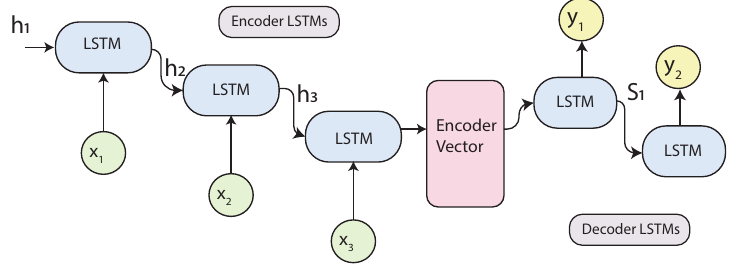
Figure 7. Sequence to Sequence model.